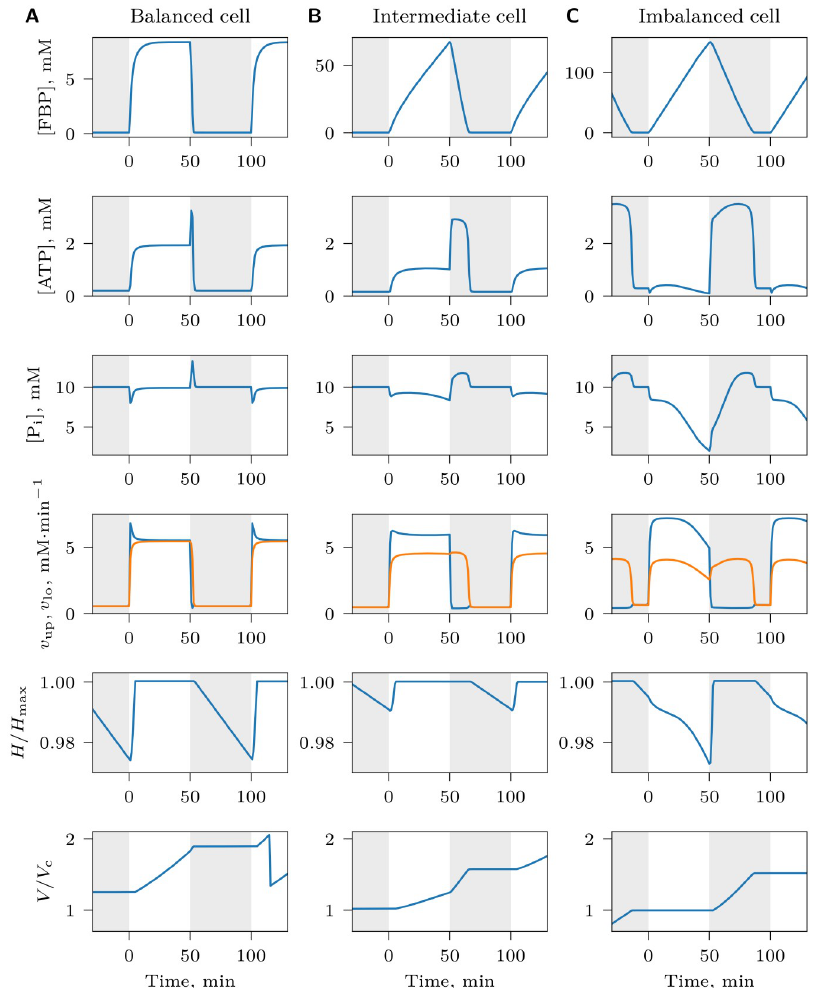
Fig 3. Metabolite and growth dynamics of individual cells under NCG conditions with an alternating high and low supply of glucose. Dynamics of (A) a balanced cell, B p,phs = 1.45 mM, (B) a cell that is neither strongly balanced nor strongly imbalanced, B p,phs = − 0.03 mM, and (C) an imbalanced cell, B p,phs = − 2.13 mM. Regions with white and gray background indicate alternating glucose supply ON phase ([Glc] 0 = 2mM) and OFF phase ([Glc] 0 = 0.01mM), respectively. In the v up , v lo plot, v up is shown in blue and v lo in orange. Time is shown relative to the beginning of a ON-OFF cycle. Note the different scales of FBP dynamics in (A), (B) and (C). In (A), a sudden drop in V / V c indicates a cell